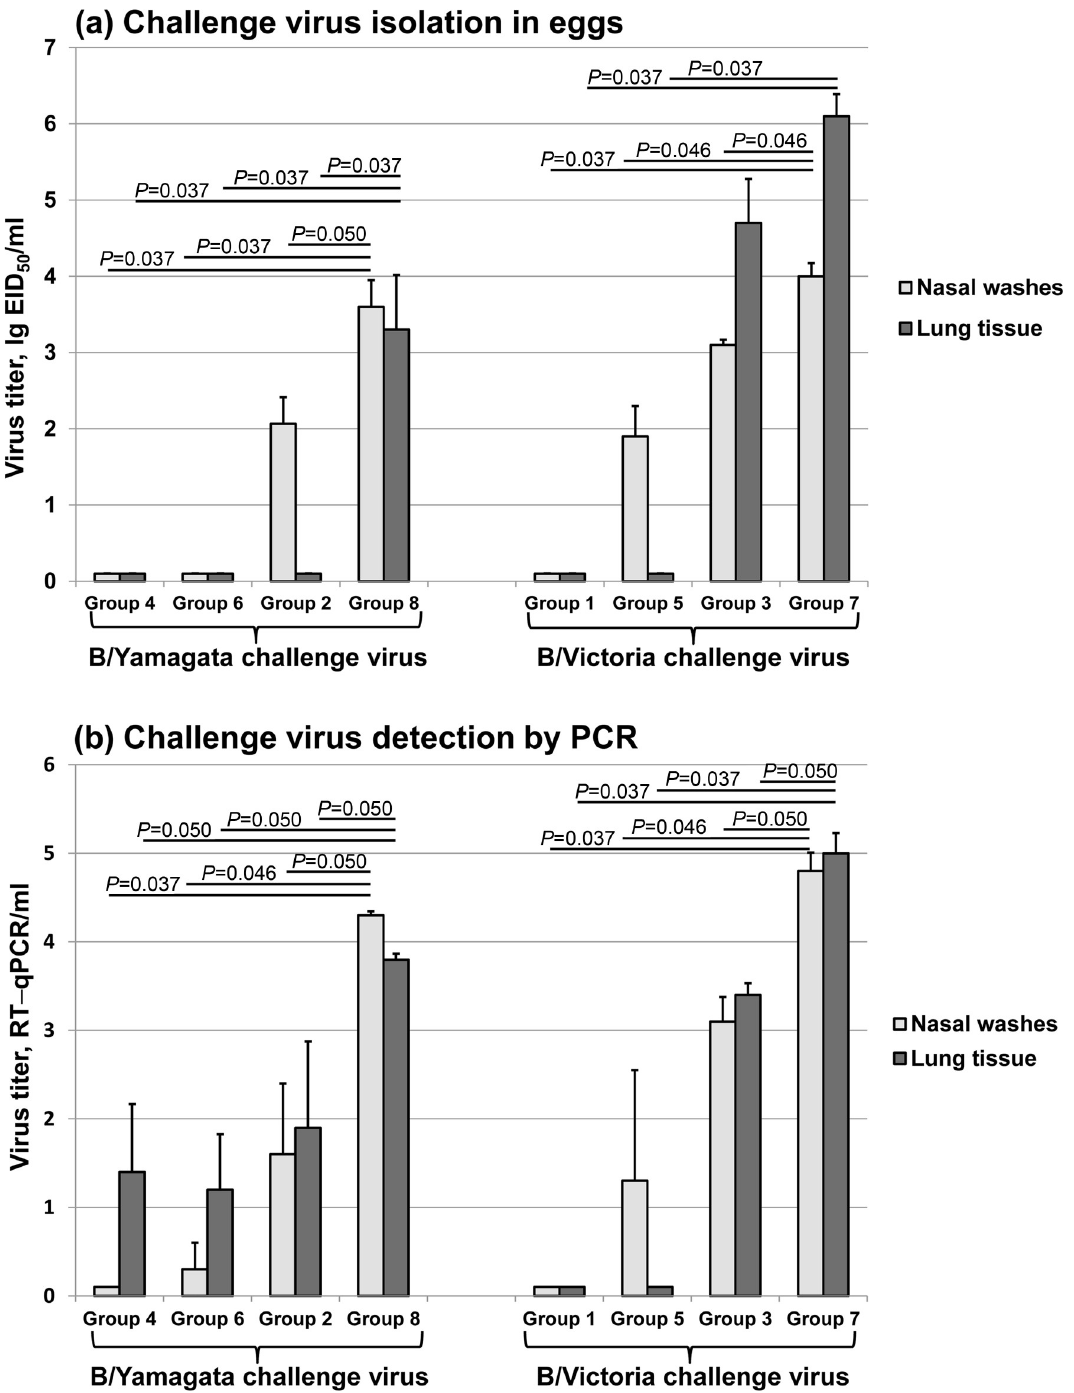
Fig 3. Detection of challenge virus in ferrets. (a) detection of challenge virus by culturing test samples in embryonated eggs; (b) detection of challenge virus in test samples by quantative RT-PCR. P values (Mann-Whitney U test) are stated. T-LAIV (B/Vic) + WT B/Vic (group 1); T-LAIV (B/Vic) + WT B/Yam (group 2); T-LAIV (B/Yam) + WT B/Vic (group 3); T-LAIV (B/Yam) + WT B/Yam (group 4); Q-LAIV + WT B/Vic (group 5); Q-LAIV + WT B/Yam (group 6); WT B/Vic (control of challenge virus, group 7); WT B/ Yam (control of challenge virus, group 8).